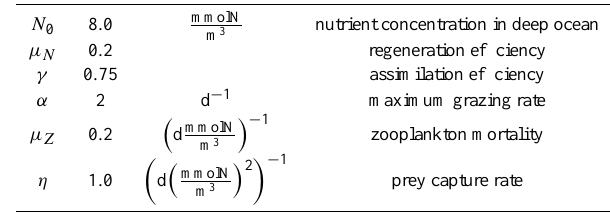
Table 3. Ecological parameters characterizing the two functional groups of phytoplankton.